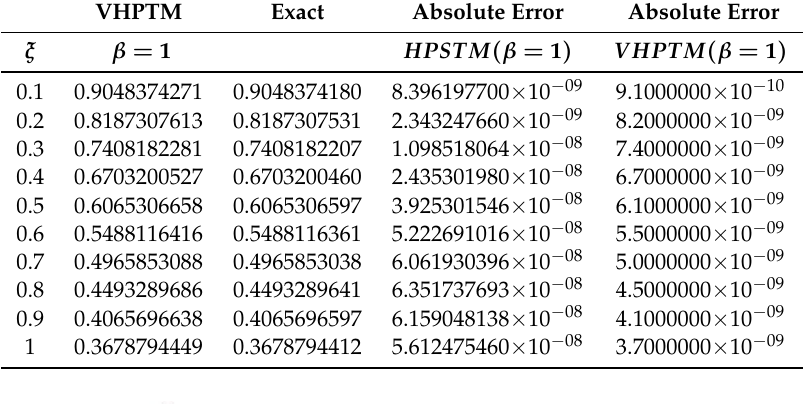
Figure 6. The obtained solutions support the convergence phenomena of the solution of fractional-order problems to the solution of integer-order problem for the example 4.3. Table 2. Comparison of VHPTM and HPSTM [11] of example 4.3 at η = 0.0000001.